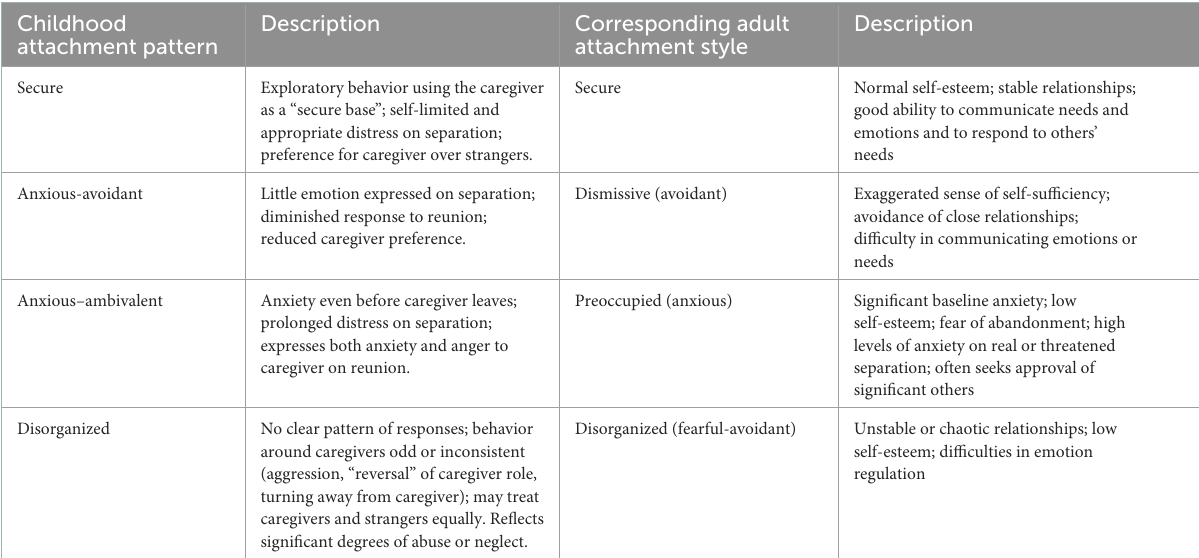
TABLE 1 Attachment styles in childhood and adulthood. Childhood attachment